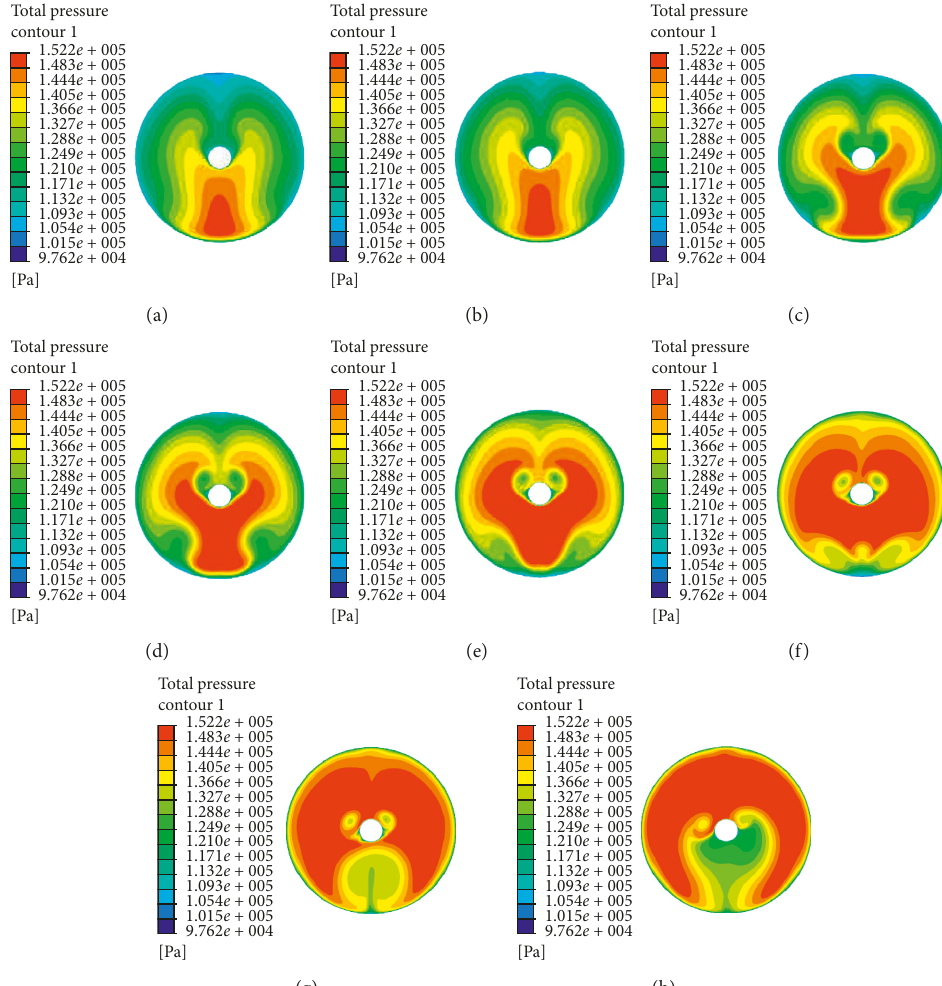
Figure 9: Total pressure distribution contours at the outlet section of inlet passage with different IVRs. (a) 0.54, (b) 0.59, (c) 0.67, (d) 0.78, (e) 0.94, (f) 1.18, (g) 1.64, and (h)